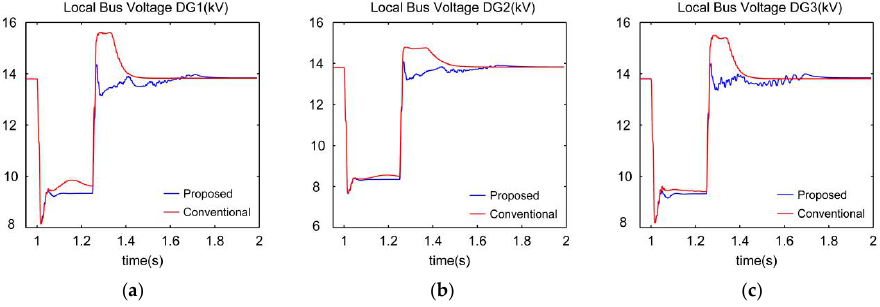
Figure 20. Voltage response of DG’s in short circuit condition using proposed supplementary control compare with conventional droop controller ( a ) DG1; ( b ) DG2; and ( c ) DG3.